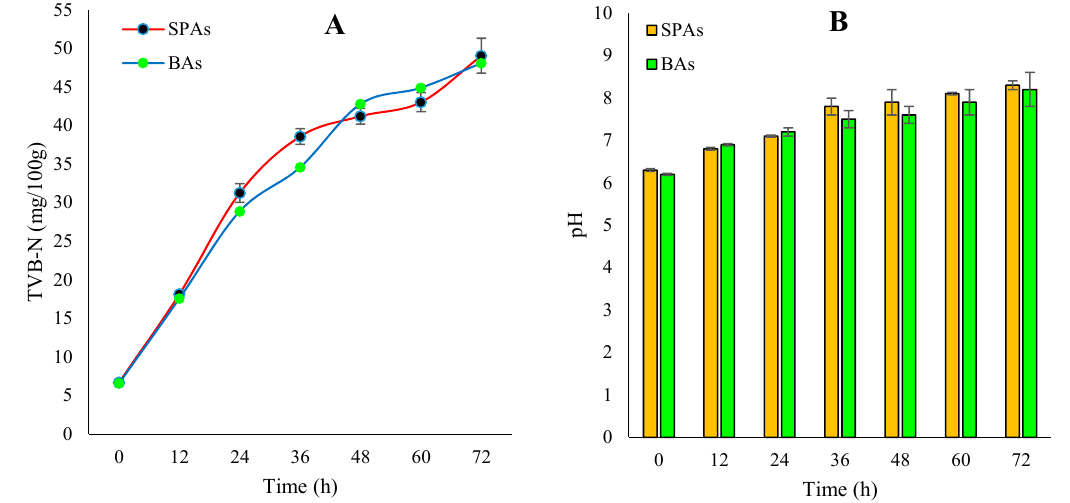
Figure 7. Quality status of fish during storage: ( A ) determination of TVB-N levels and ( B ) determina- tion of pH.